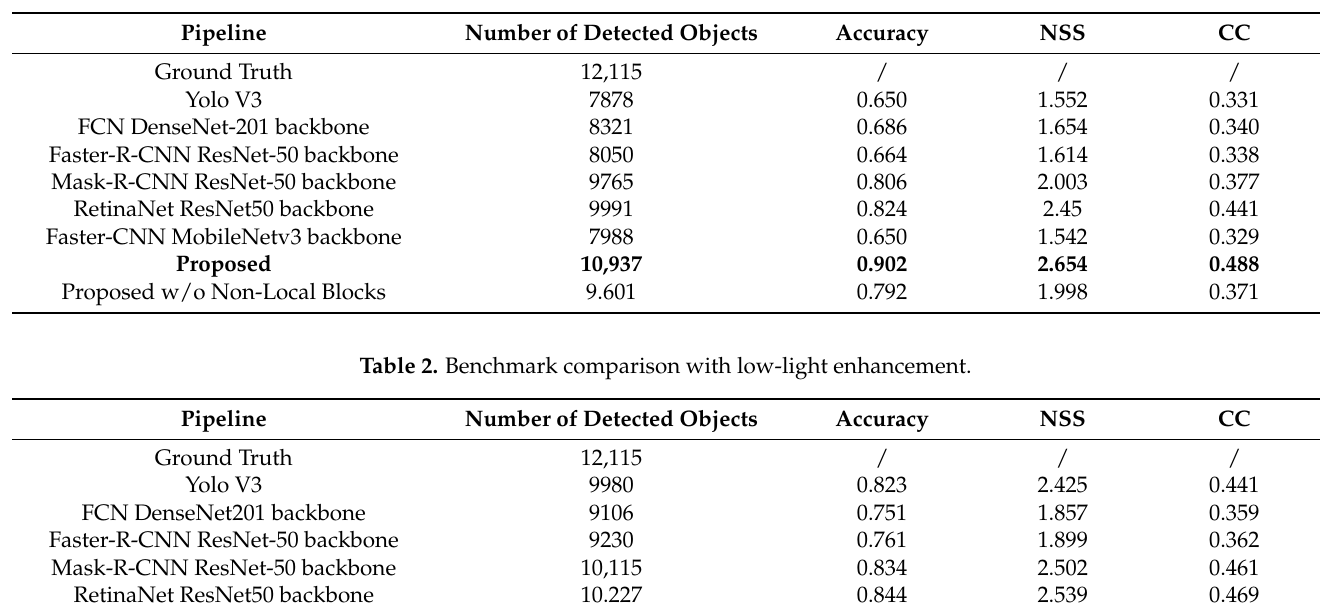
Table 1. Benchmark comparison with similar pipeline without low-light enhancement.